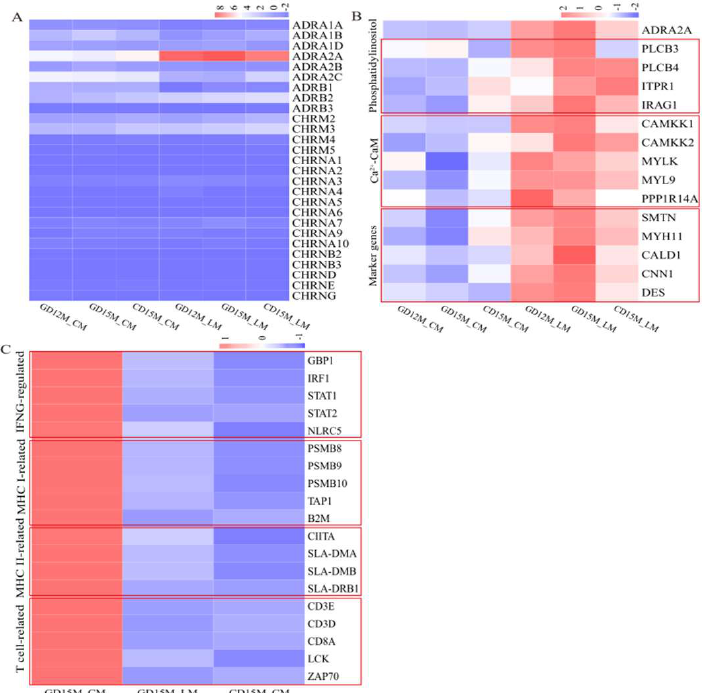
Figure 3. Heatmaps of the DEGs. ( A ) Heatmap of adrenergic and cholinergic receptor genes in M_CM and M_LM on GD12, GD15, and CD15. ( B ) Heatmap of genes in the phosphatidylinositol and Ca 2+ –CaM signaling pathways in M_CM and M_LM on GD12, GD15, and CD15. ( C ) Heatmap of immune response processes–related genes in M_CM and M_LM on GD15 and M_CM on CD15. GD12, day 12 of pregnancy; GD15, day 15 of pregnancy; CD15, day 15 of the estrous cycle; M, the mesometrial side of the uterus; CM, the circular muscle of myometrium; LM, the longitudinal muscle of myometrium; DEGs, differentially expressed